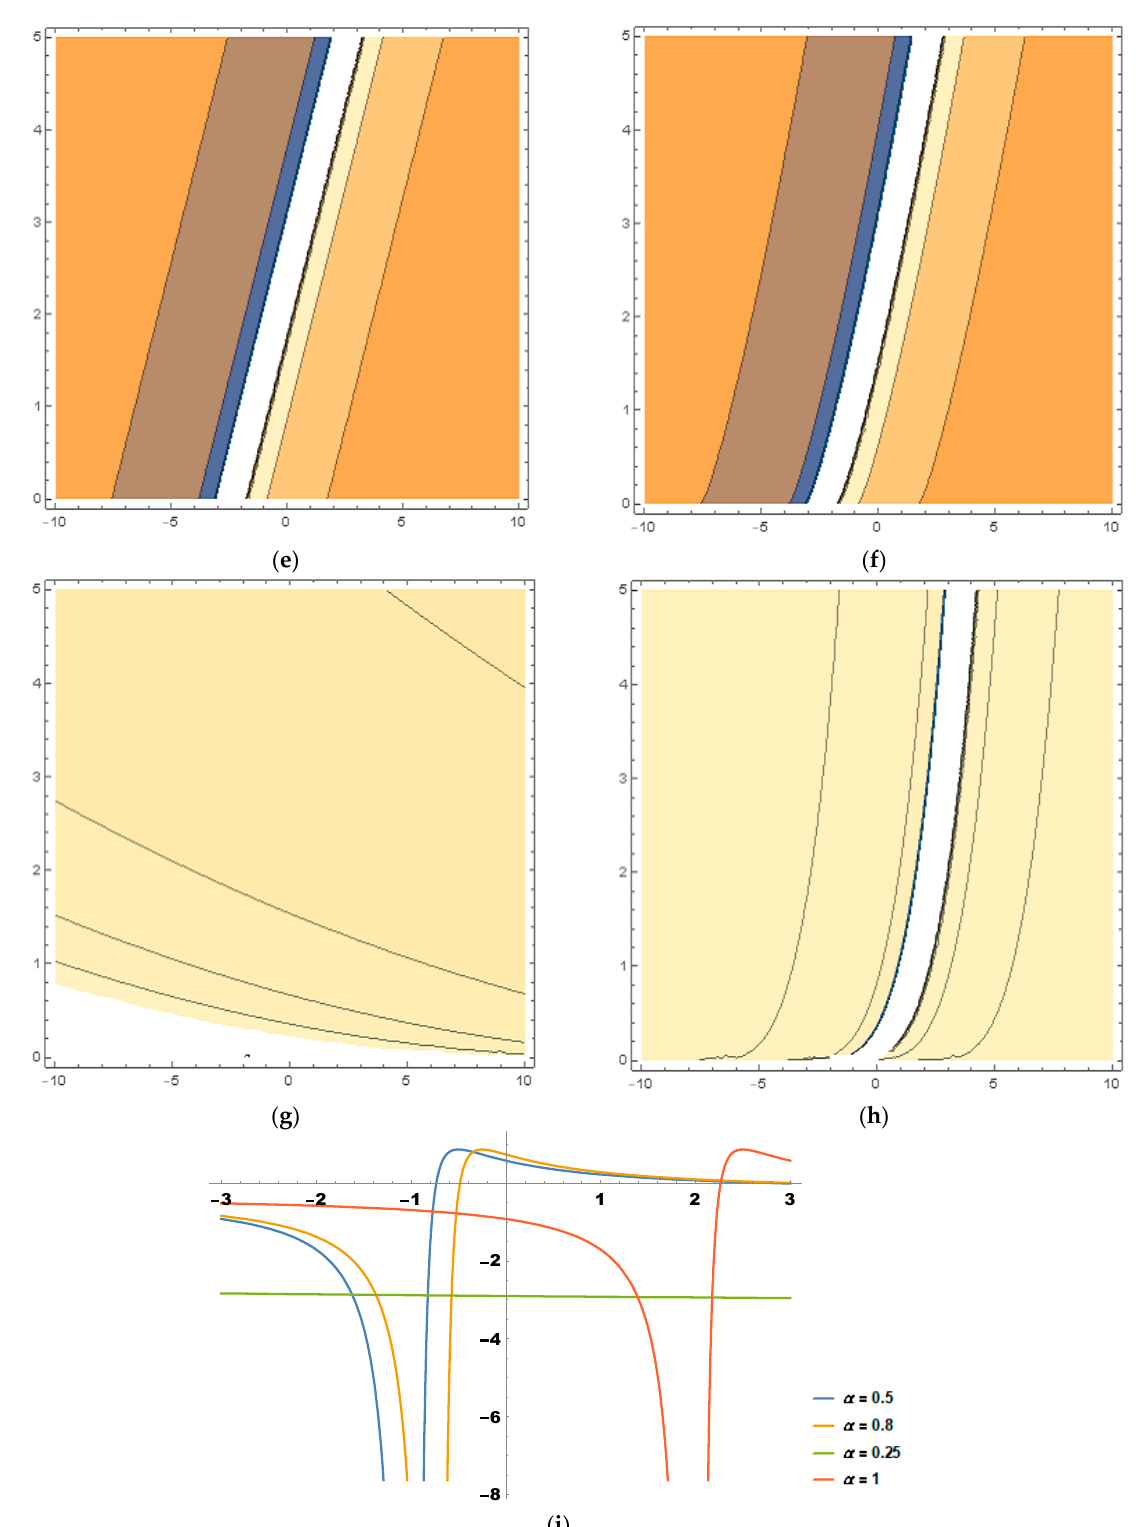
Figure 6. For Equation (33), ( a – d ) with − 10 ≤ x ≤ 10 and 0 ≤ t ≤ 5 indicate the 3D profiles, ( e – h ) express the contour profiles for − 10 ≤ x ≤ 10 and 0 ≤ t ≤ 5, and ( i ) indicates the 2D representation of a range of values of α . ( a ) α = 1, ( b ) α = 0.8, ( c ) α = 0.5, ( d ) α = 0.25, ( e ) α = 1, ( f ) α = 0.8, ( g ) α = 0.5, and ( h ) α =